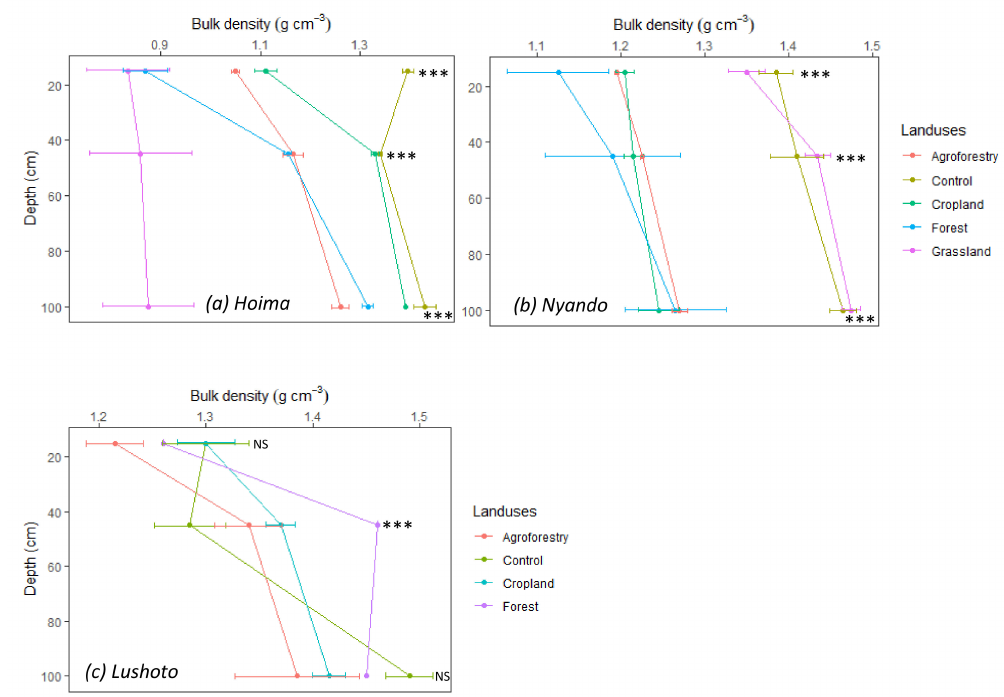
Figure 4. Bulk density at di ff erent soil depths (0–100cm). Cropland, agroforestry, grassland, forest, and control land uses. Error bars show standard error of the mean. NS: non-significant, ***, **, and * indicate significant di ff erences at p ≤ 0.001, p ≤ 0.01, and p ≤ 0.05,